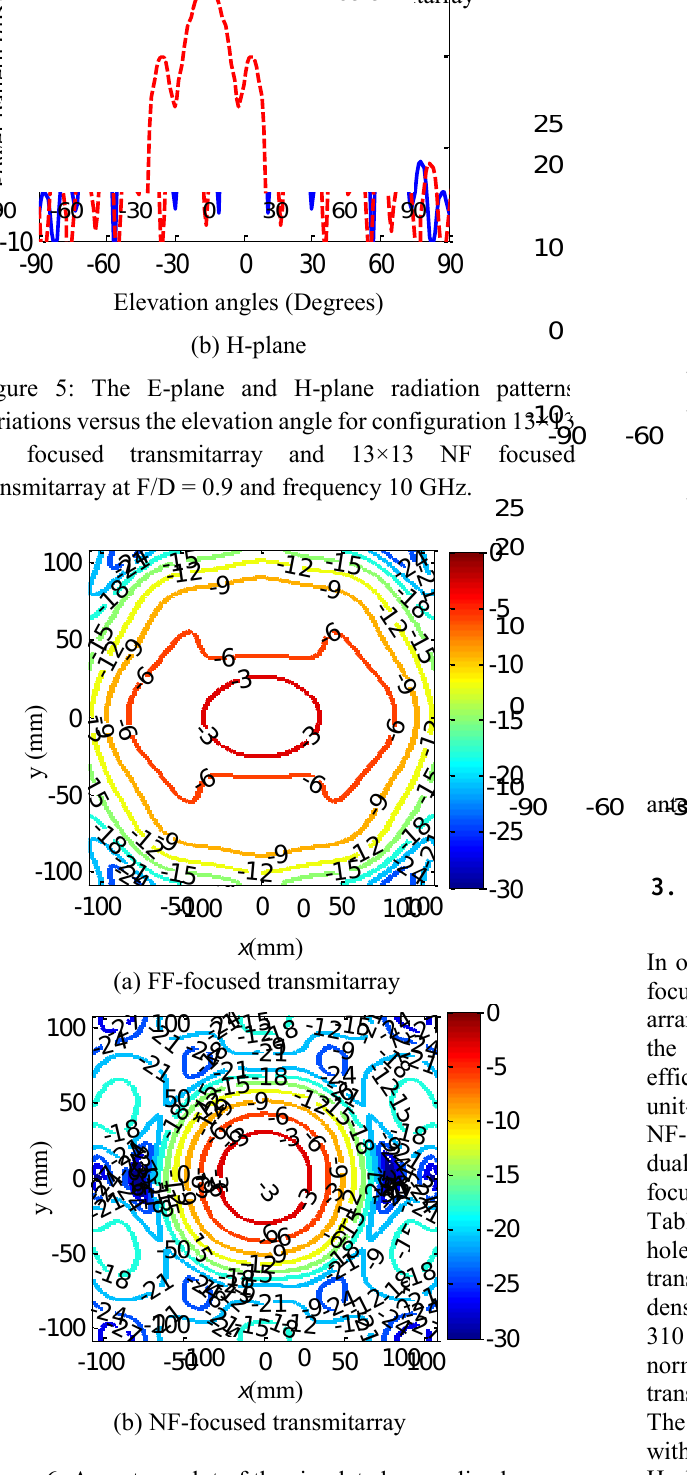
Figure 6: A contour plot of the simulated normalized power density of the 13x13 transmitarray in in x-y plane for both FF- focused transmitarray and NF-focused transmitarray at R o = 310 mm.